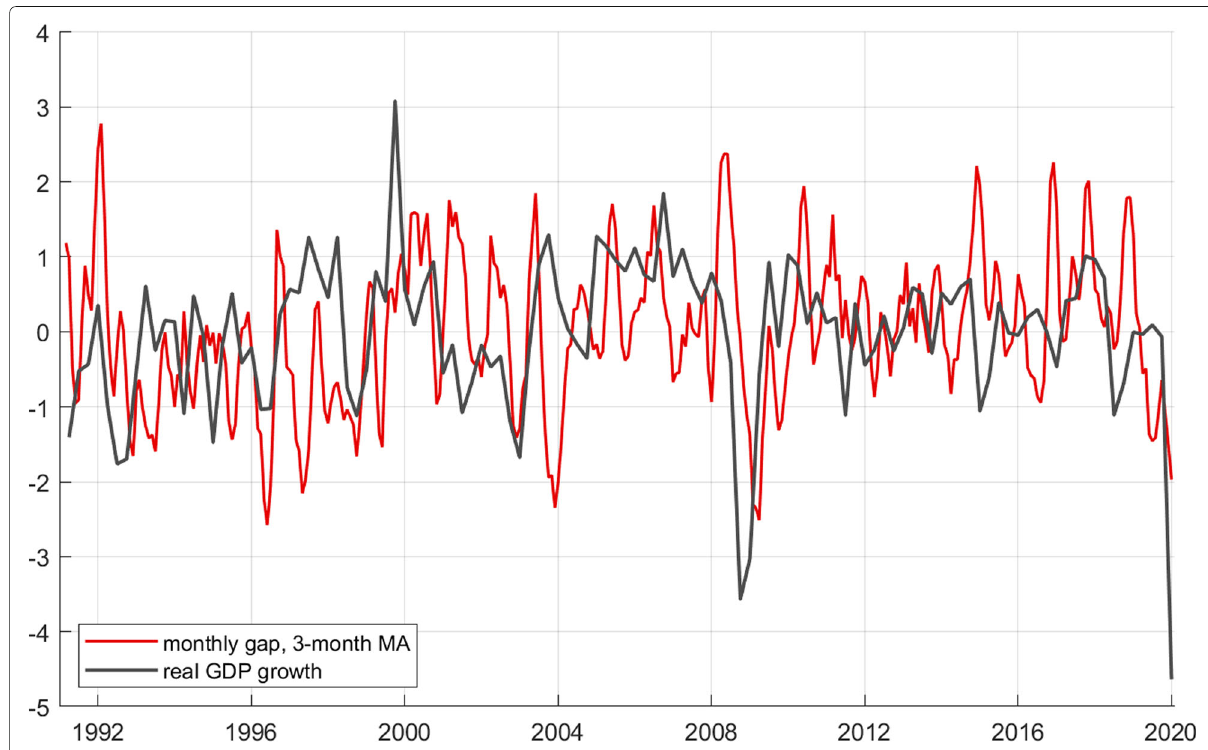
Fig. 9 Real GDP quarterly growth rates in black, and 3-month central moving average of relative monthly electricity gap ( g ) in red. Data are normalized to have zero mean and unit